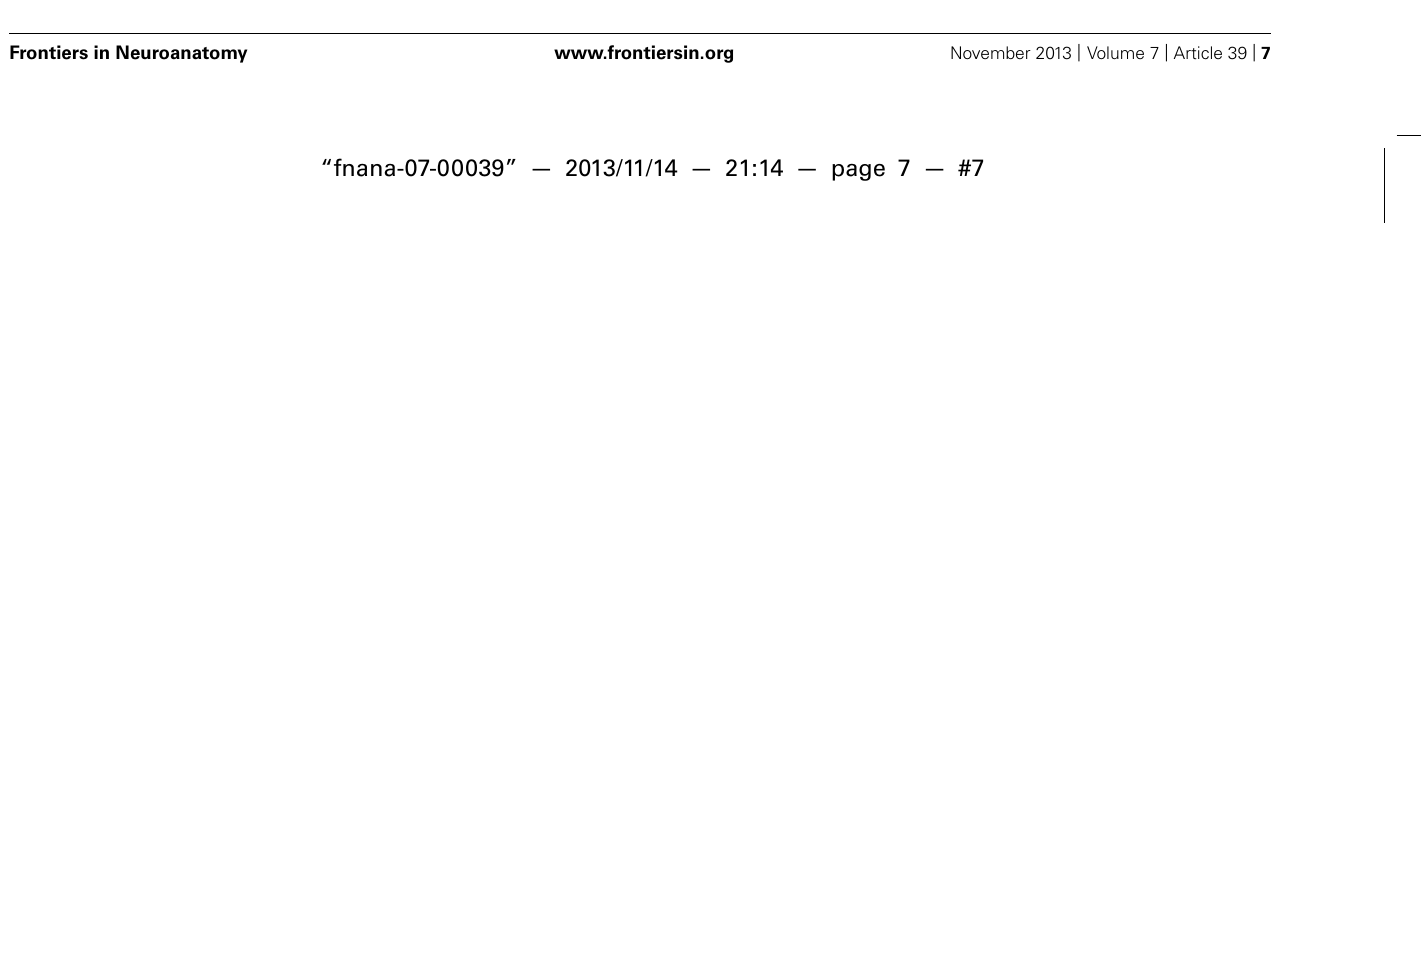
FIGURE 4 |Topography of the naked mole-rat cerebellum with electrophysiological mapping of cutaneous and periodontal responses from the lobulus simplex A and B, ansiform lobule and pyramis. (A) Schematic of the microelectrode-derived map of cutaneous inputs to the cerebellum labeled according to corresponding